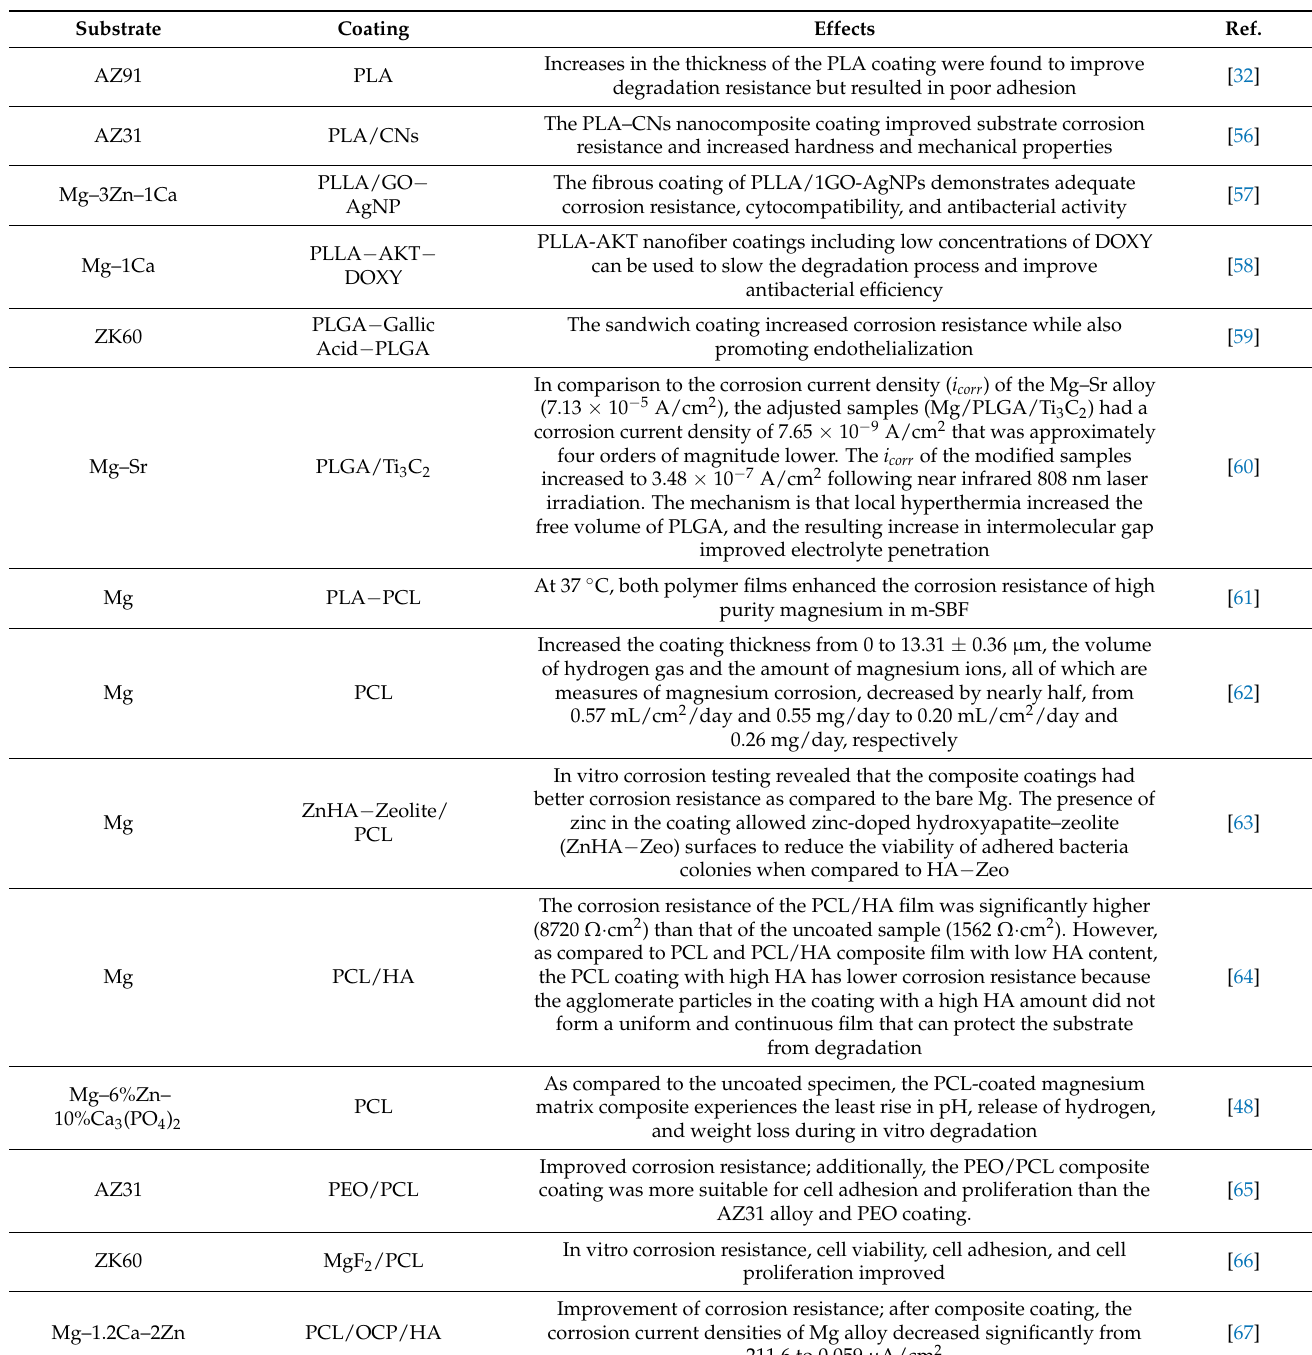
Table 1. Effects of synthetic polymer coatings and composite coatings parameters on Mg-based material